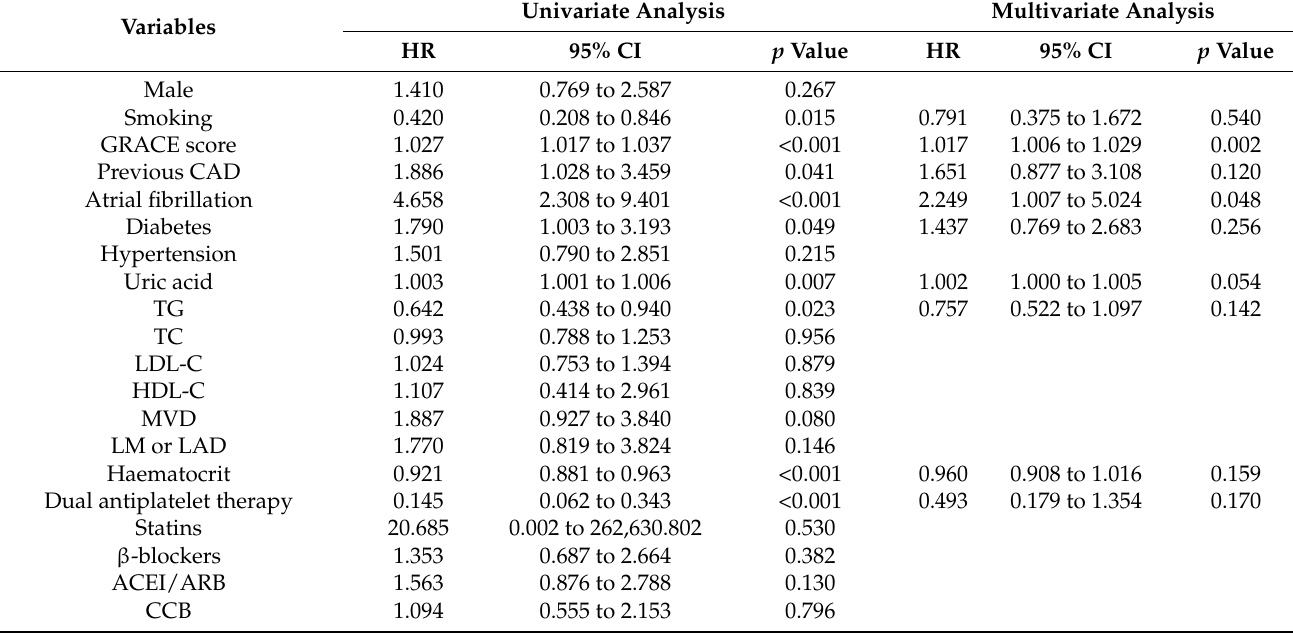
Table 2. Univariate and multivariate Cox regression analysis for all-cause mortality.